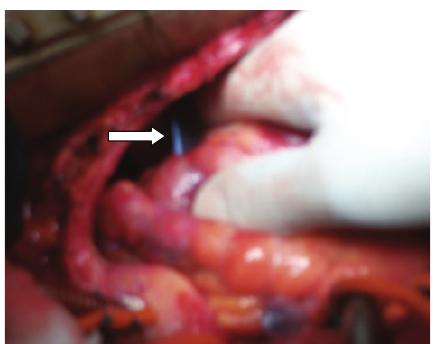
Figure 2: Operative view after cardiopulmonary bypass